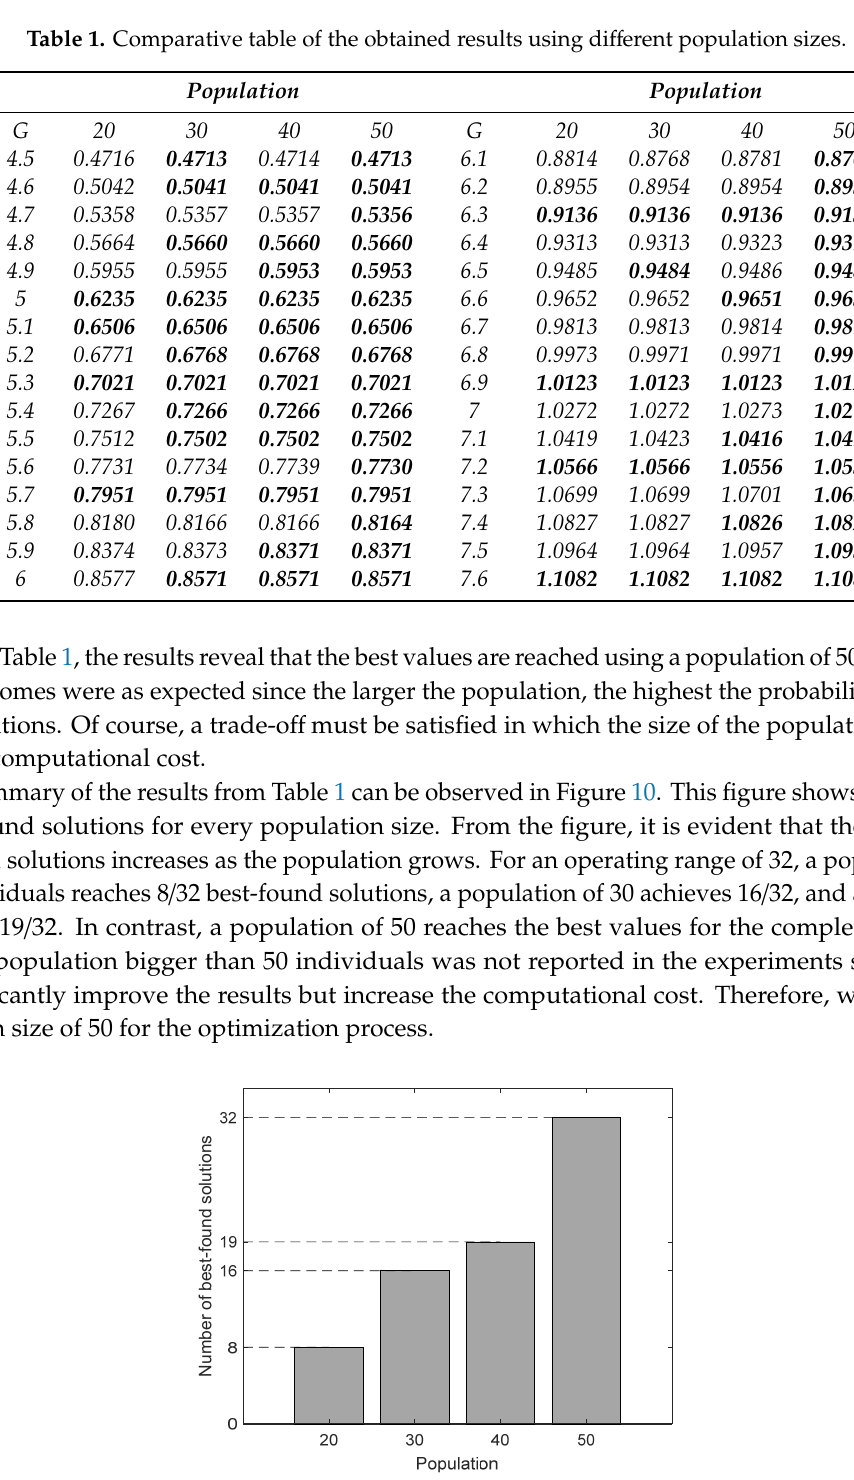
Figure 10. The number of best-found solutions for different population sizes.